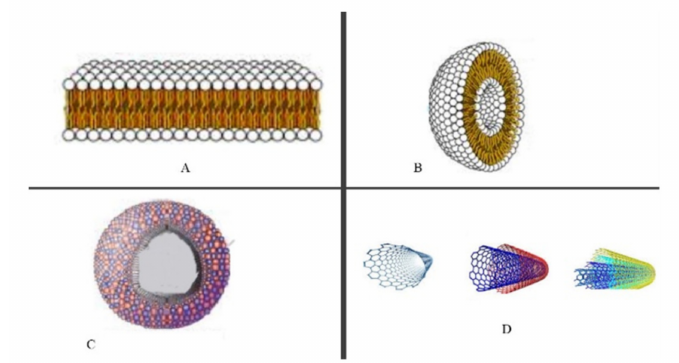
Figure 2. ( A ) Lipid bilayer, ( B ) Liposomes, ( C ) Vesicles, ( D ) Nanotubes. A lipid bilayer is composed of amphiphilic molecules characterized by a polar (hydrophilic) head and a non-polar (hydrophobic) tail. Bilayers tend to form sheets and form globular structures exposing the hydrophilic moiety to the external aqueous environment. Liposomes and vesicles present a very similar supramolecular structure. They both have an inner lumen containing water. This makes a good tool to entrap molecules to be delivered across the lipid cell layer of the cell membrane. Carbon nanotubes (CNT) consist of single sheets of graphene, but double and multi-layer tubes on nanometric size (from left to right in section ( D ) of the figure). From the chemical point of view, CNTs are very different from vesicles and liposomes since they are formed by a carbon allotrope like diamond and graphite. The size of all particles: liposomes, vesicles, and CNTs range from a few tens to hundreds of nanometers. Just to give an idea, CNTs have a diameter approximately 50,000 times smaller than a human hair) but they can be up to several centimeters